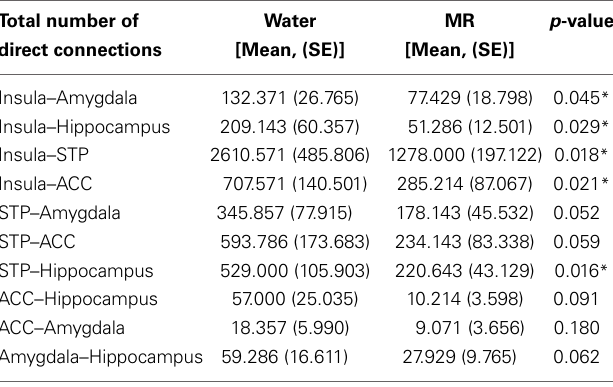
Table 2 | Summary of direct connections between nodes of the